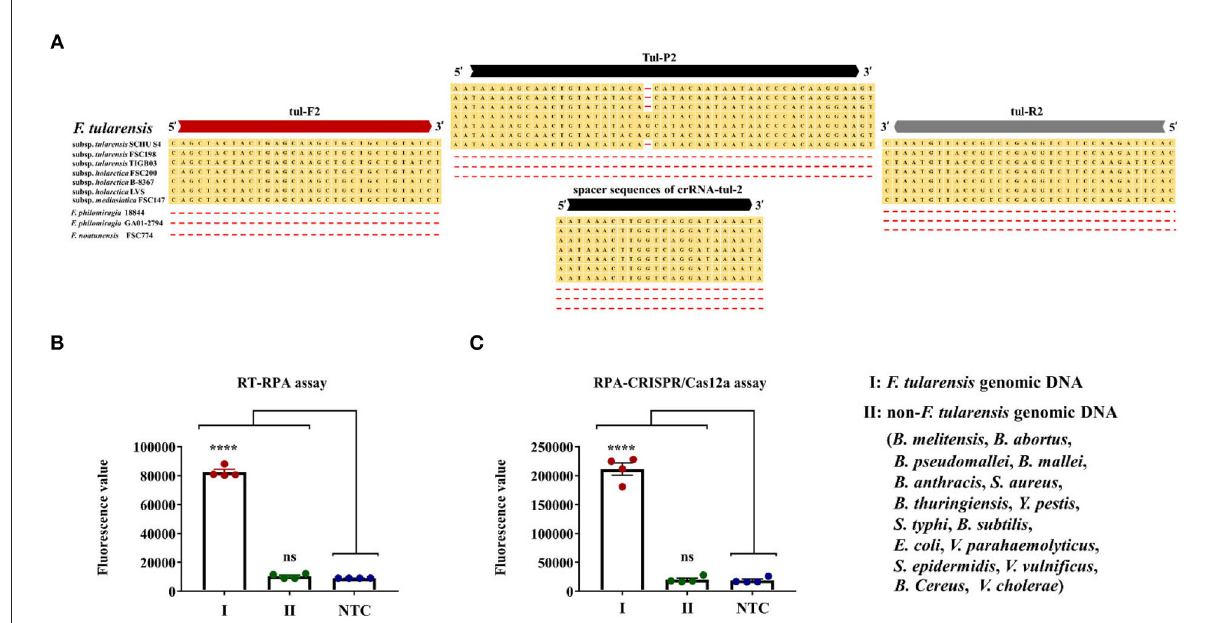
FIGURE4 Specificity evaluation of RT-RPA and RPA-CRISPR/Cas12a assays. (A) Sequence alignment of tul-F2/R2, tul-P, and spacers sequence of crRNA-tul-2 with multiple F. tularensis strains and F. philomiragia and F. noatunensis . (B) Specificity evaluation of RT-RPA assay. (C) Specificity evaluation of the RPA-CRISPR/Cas12a assay. Error bars represent mean ± SEM, where n = 4 replicates, t -test, **** ( P < 0.0001), ns (non-significant).